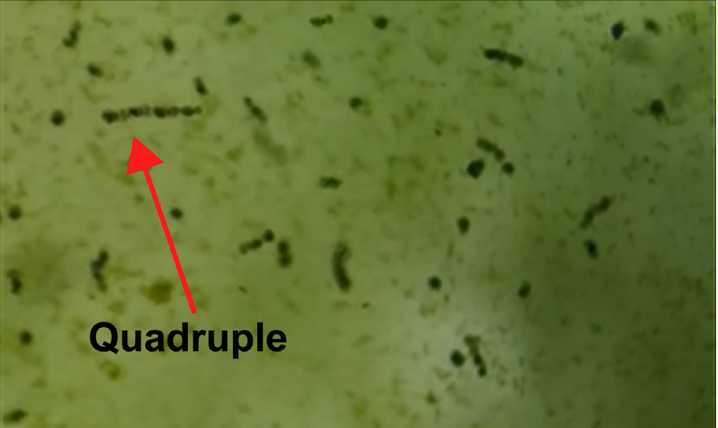
Fig 1. The phenomenon of linear aggregation observed by